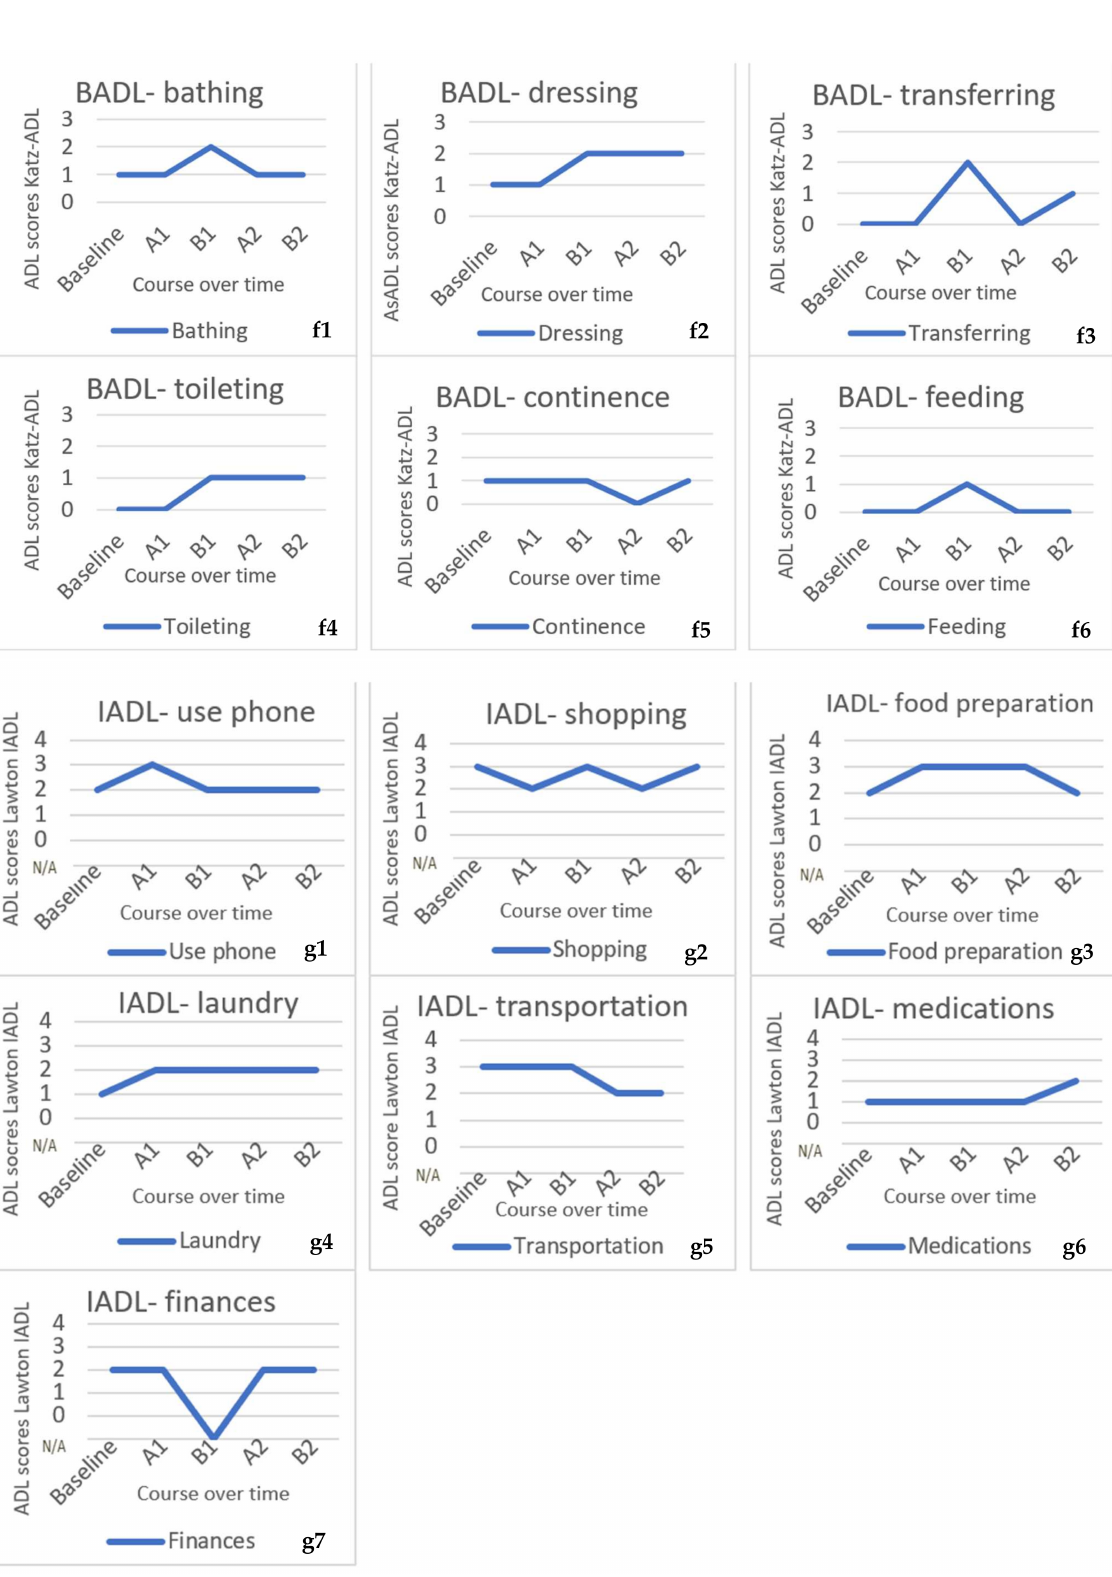
Figure 8. ( a ) Scores washing; ( b ) Scores dressing; ( c ) Scores food preparation; ( d ); Scores medication intake; ( e ) Scores housekeeping; ( f1 – f6 ) Scores Katz-ADL; Baseline = before start of the first phase; B1 = scores at the end of intervention phase one; A1 = scores at the end of placebo phase one; B2 = scores at the end of intervention phase two; A2 = scores at the end of placebo phase two; ( g1 – g7 ) Scores Lawton IADL; Baseline = before start of the first phase; B1 = scores at the end of intervention phase one; A1 = scores at the end of placebo phase one; B2 = scores at the end of intervention phase two; A2 = scores at the end of placebo phase